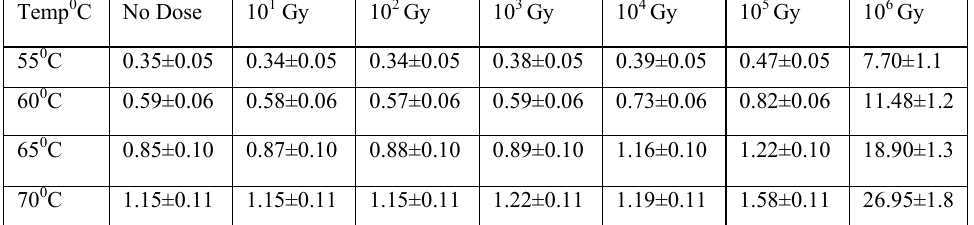
Table 1. Bulk-Etch rate (V ) in µm/h for pre-gamma exposed PADC –American Acrylics. G